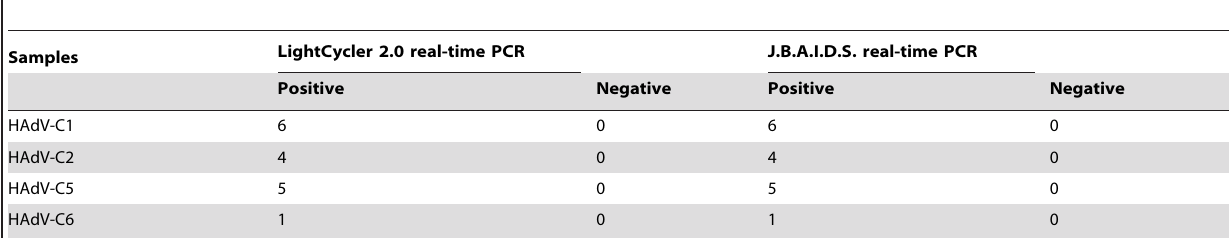
Table 1. Summary of Human adenovirus (HAdV) detection by real-time PCR using the LightCycler 2.0 and J.B.A.I.D.S. in cultured isolates from the CDPH.